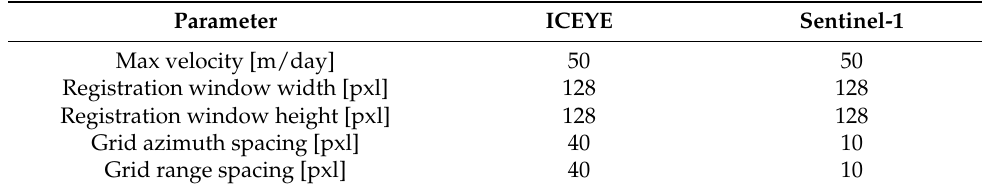
Table 2. Parameters selected for calculations using the offset-tracking technique.